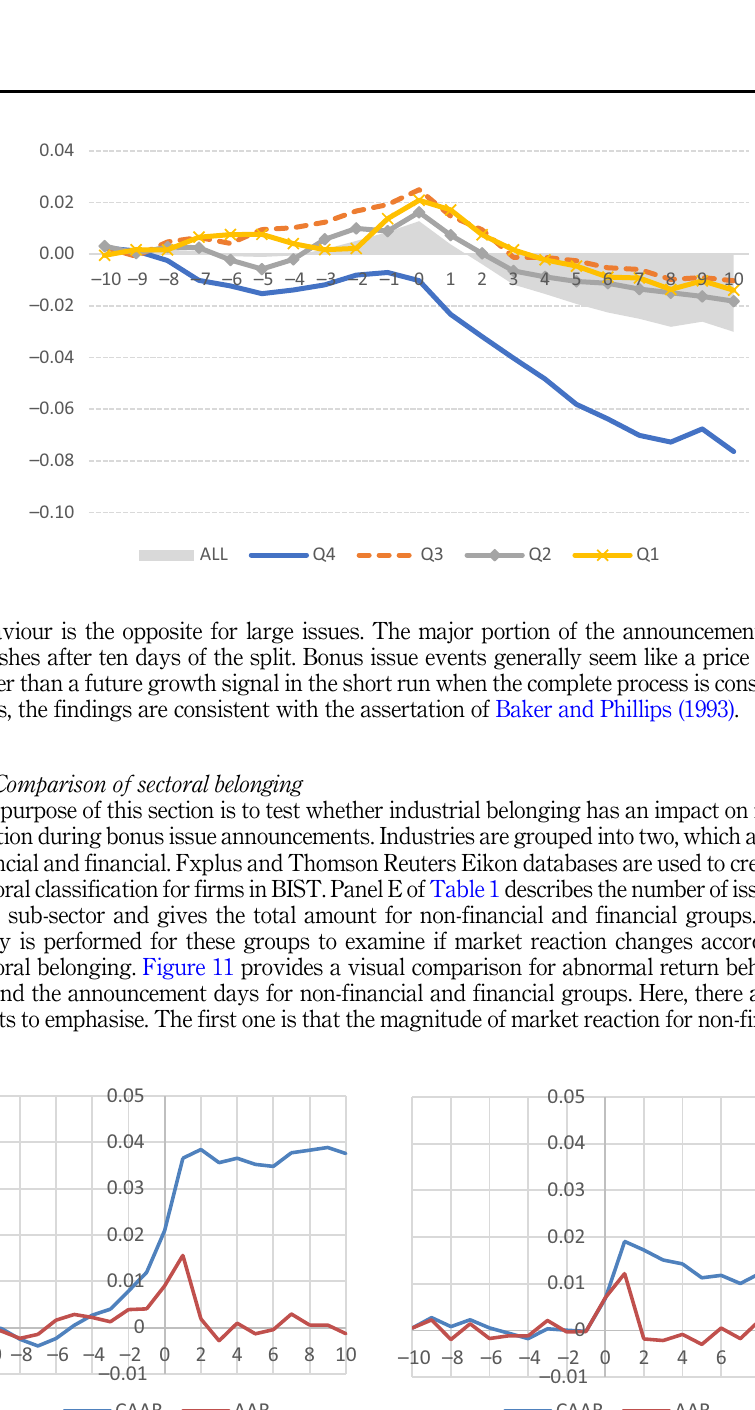
Figure 11. Market reaction of sectoral